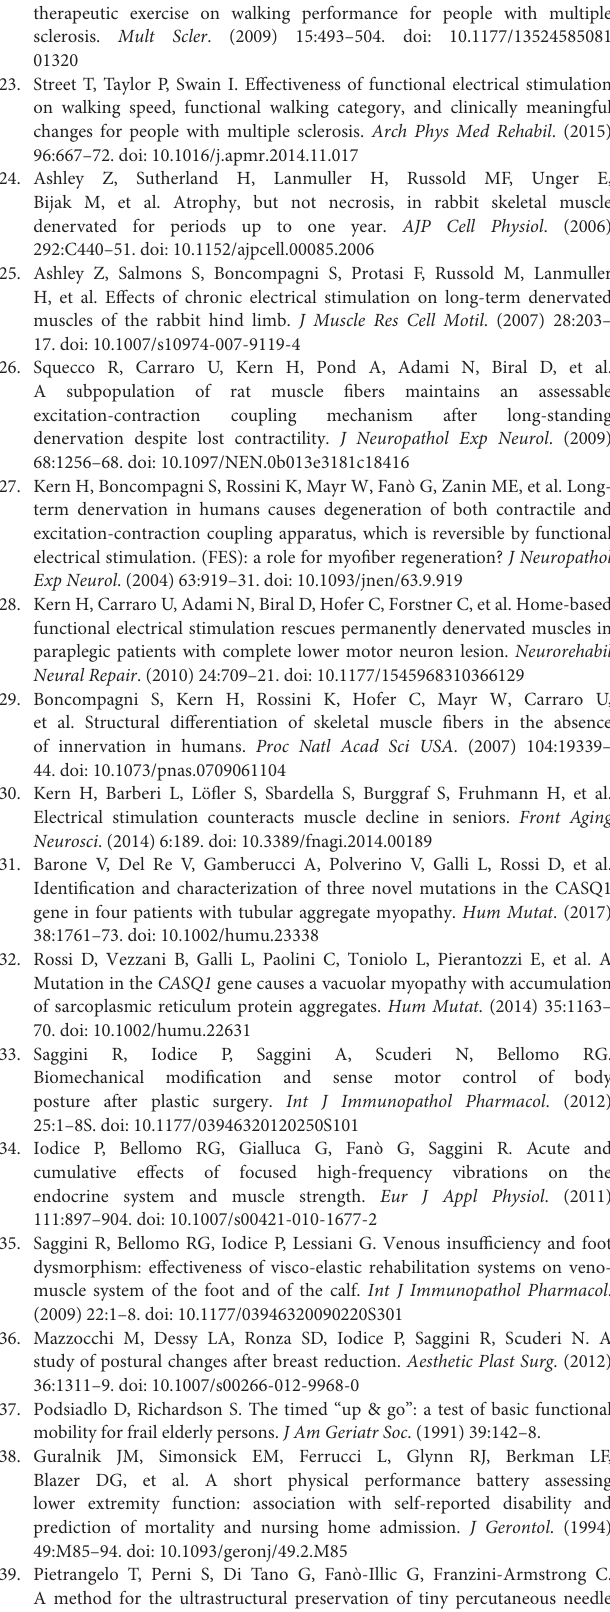
Frontiers in Neurology |